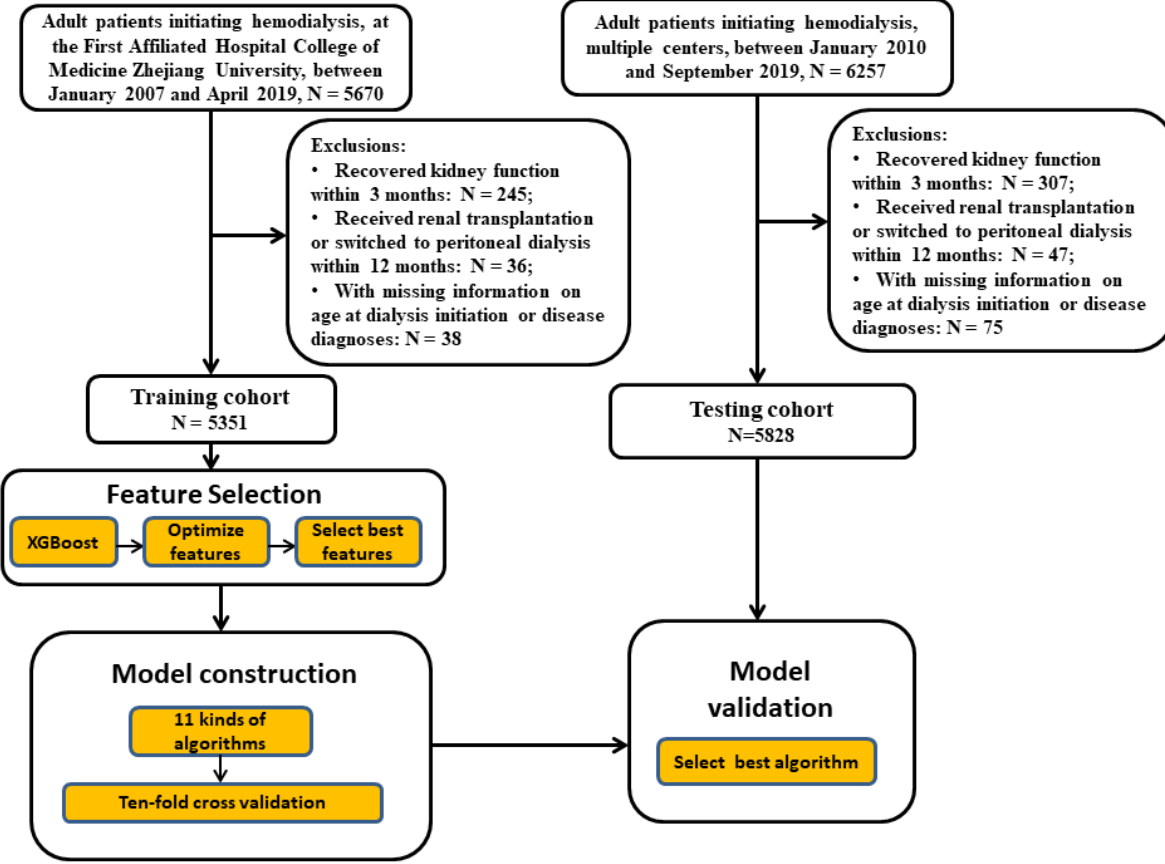
Adult patients (aged ≥ 18 years) with end-stage renal